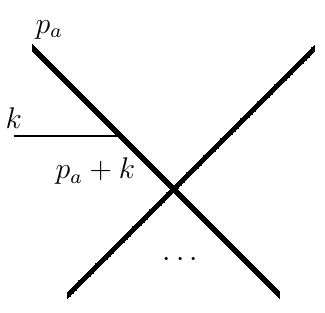
Figure 2 . A Feynman diagram like representation of (3.17), with the external thin line carrying momentum k labelling the argument of b T (cid:22)(cid:23) ( k ), the external thick lines representing the incoming and the outgoing particles and the internal propagator carrying momentum p a + k representing the 1 = f i ( p a :k (cid:0) i(cid:15) ) g factor. All momenta are labelled as outgoing, so an incoming particle is represented with negative p 0 . The vertex where the lines representing incoming and outgoing particles meet a represent the interaction region R in (cid:12)gure 1. The vertex where the external thin line representing b T (cid:22)(cid:23) ( k ) meets the a -th thick line carries the p (cid:22) a p (cid:23) a factor in